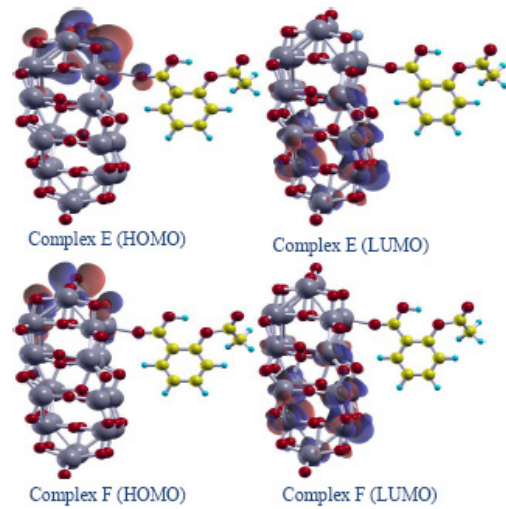
Fig. 11. The isosurfaces of HOMO and LUMO molecular orbitals of the studied systems consisting of the aspirin molecule adsorbed on the TiO2 nanoparticles for perpendicular configuration. The orange and blue colors represent the positive and negative value areas respectively.